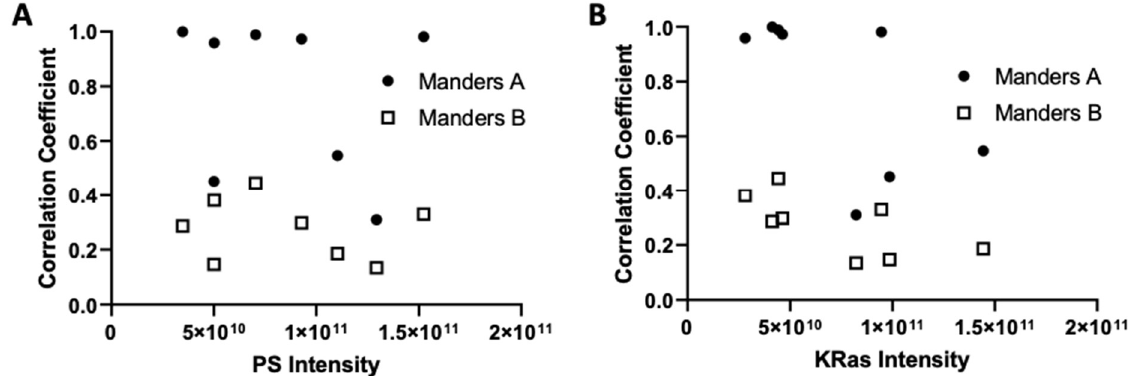
Figure A2. Independence of DNA-PAINT image signal intensity measured using Image J and colocalization coefficients obtained from Coloc-Tesseler. ( A ) The scatterplot shows the whole cell intensity of the PS channel normalized to area plotted against both the Manders A (circles) and B (squares) colocalization coefficients of eight KRas-G12D U2OS cells with PS (each symbol represents one cell in the plot). ( B ) The scatterplot shows the whole cell intensity of the KRas channel normalized and plotted in the same way. Both plots show no relationship between intensity levels of either PS or KRas, and colocalization coefficients describing their co-organization, which rules out that increased co-organization is simply due to higher levels of probes.